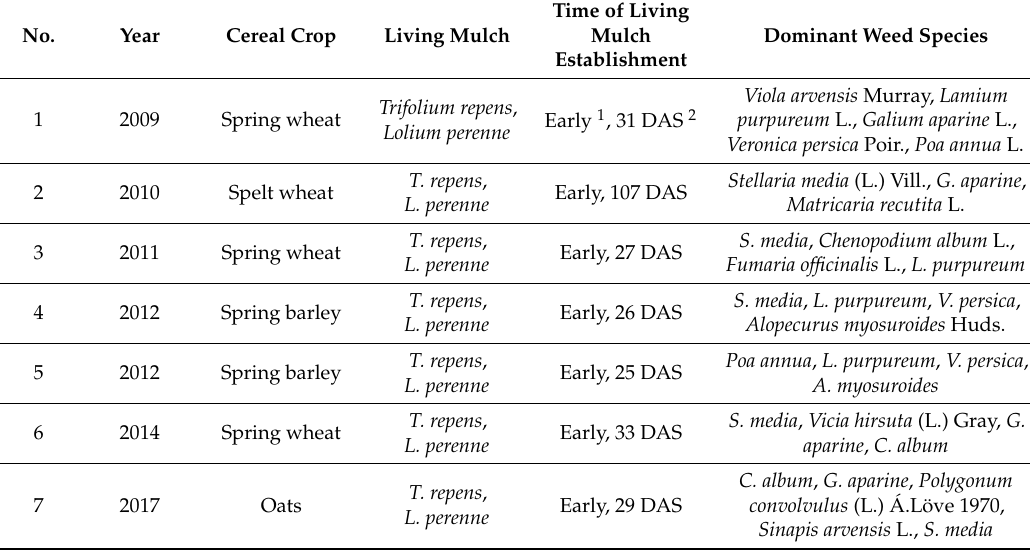
Table 1. Details of the field experiments with living mulch for weed suppression. White clover and perennial ryegrass were sown between the crop rows in all experiments on the same day with the crop (early) and during tillering of the cereal